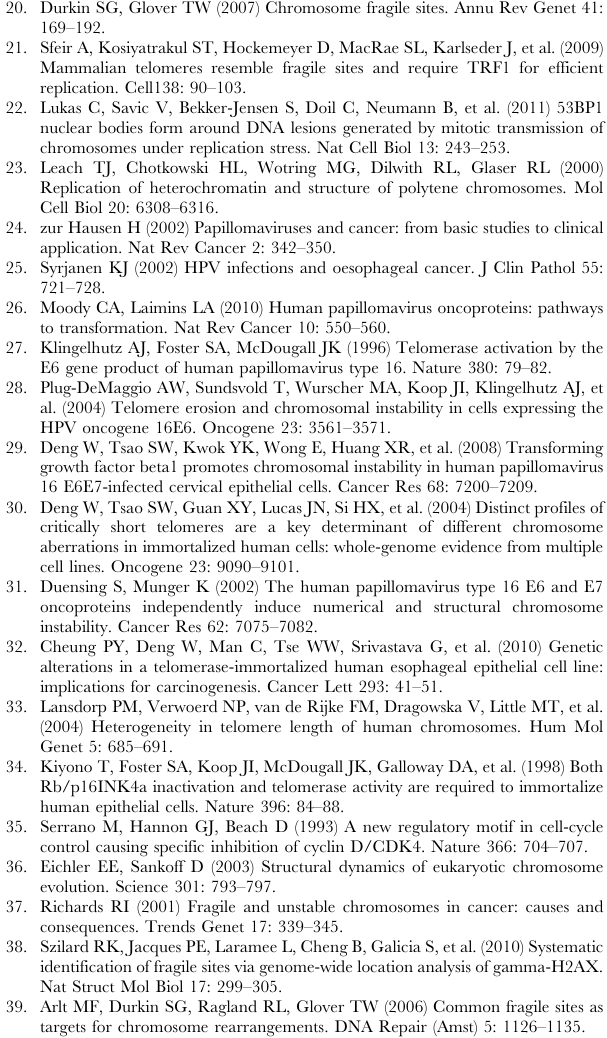
Figure S1 Typical SKY karyotypes at late passages of two immortalized esophageal epithelial cell lines ex- pressing HPV16 E6E7 and hTERT. Arrows indicate chromosomes with centromeric or pericentromeric aberrations. Figure S2 Typical SKY karyotypes at late passages of two immortalized cervical epithelial cell lines expres- sing HPV16 E6E7 and hTERT. Arrows indicate chromosomes with centromeric or pericentromeric aberrations. Figure S3 Western Blotting for p16 INK4a . Actin bands served as protein load controls. NC104 cells at PD 18 were approaching permanent growth arrest (PD20), which was included to show up-regulation of p16 INK4a for the comparison with p16 INK4a levels after HPV 16 E6E7 expression. Figure S4 Flow cytometric analysis of cell cycle dis- tributions. Only the quantitative data for percentages of S- phases were given for simplicity.